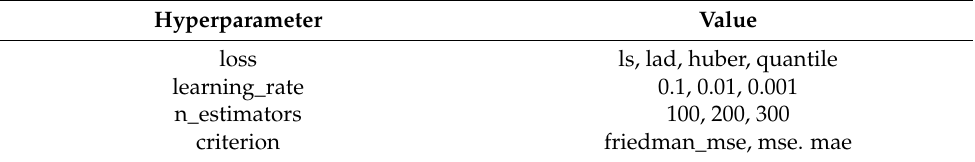
Table 4. Hyperparameters to find the optimal values for gradient boosting